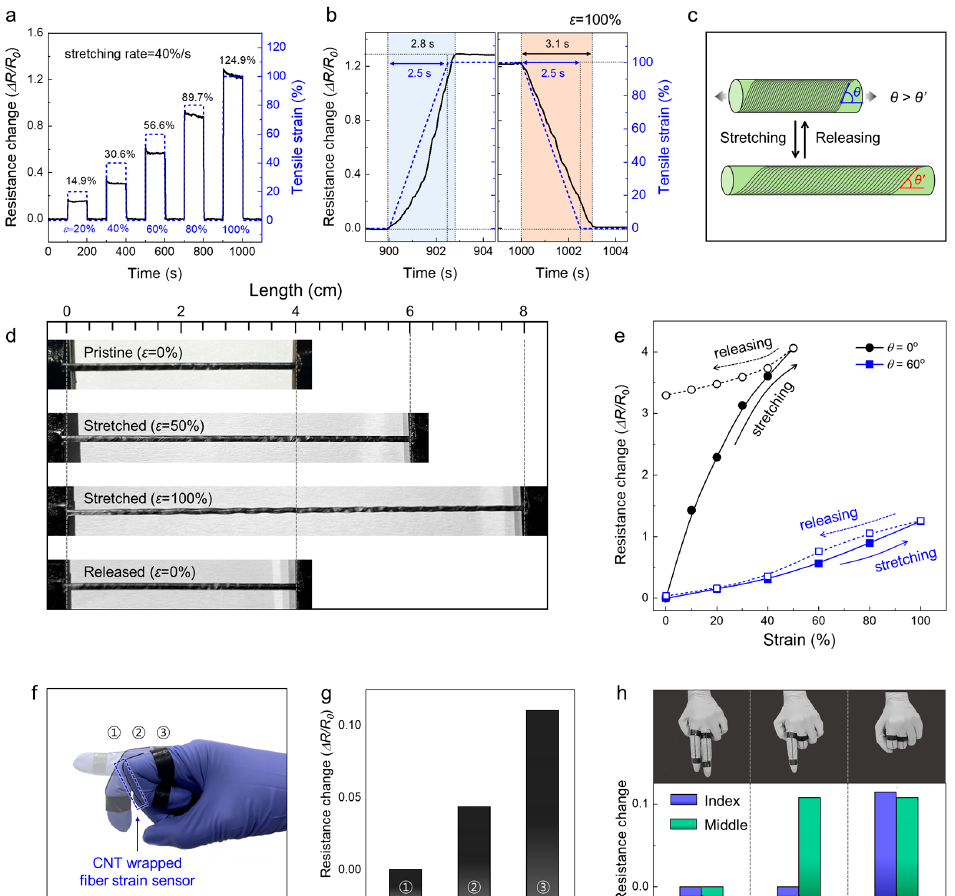
Figure 3. Electrical performances and morphological changes in CNT-wrapped core/sheath fiber strain sensor during tensile deformation. ( a ) Dynamic response curves of fiber sensors under various tensile strains (20%, 40%, 60%, 80%, 100%). ( b ) Response and recovery time of CNT-wrapped fiber strain sensor during stretching 100% and releasing to initial state. ( c ) Schematic showing the changes in the reversible CNT wrapping angle during the stretching and releasing processes. ( d ) Photographs showing the fiber in the pristine state, 50% tensile strain, 100% tensile strain, and pristine state after release. ( e ) Resistance changes versus tensile strain (from 0% to 100%) of CNT-wrapped core/sheath fiber strain-sensing fiber sensors with zero wrapping angle ( θ = 0 ◦ ) and nonzero wrapping angle ( θ = 60 ◦ ). ∆ R is the change in the fiber resistance under tensile deformation, and R 0 is the fiber resistance in the initial state. ( f ) Photograph and ( g ) response of the 5 cm long CNT-wrapped fiber strain sensor attached to the index finger with various hand motions. ( h ) Photographs of sensors attached to the index and middle fingers and resistance changes during various hand gestures.